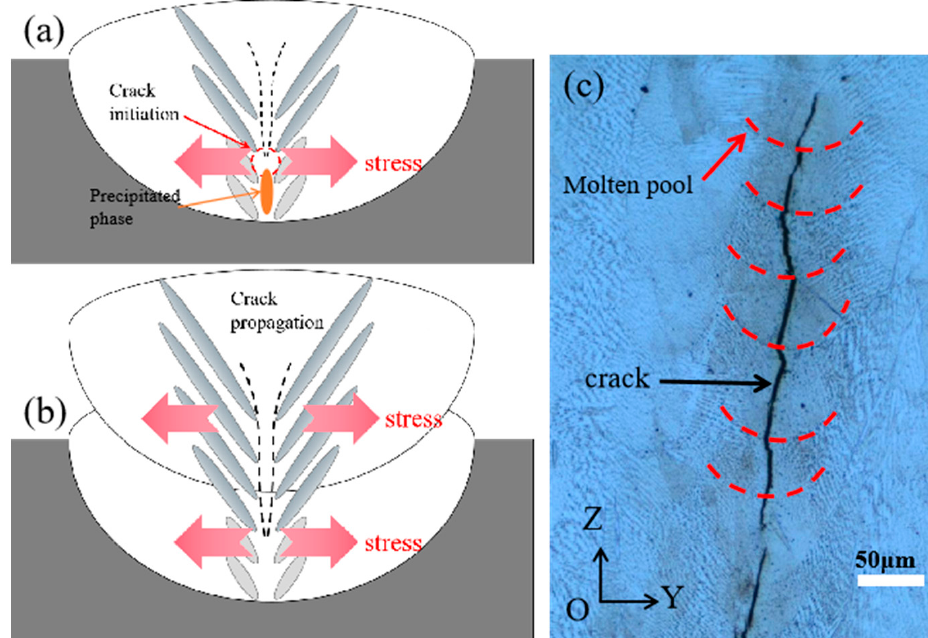
Figure 12. ( a ) Initiation of crack; ( b ) Propagation of crack; ( c ) Crack in experiment.